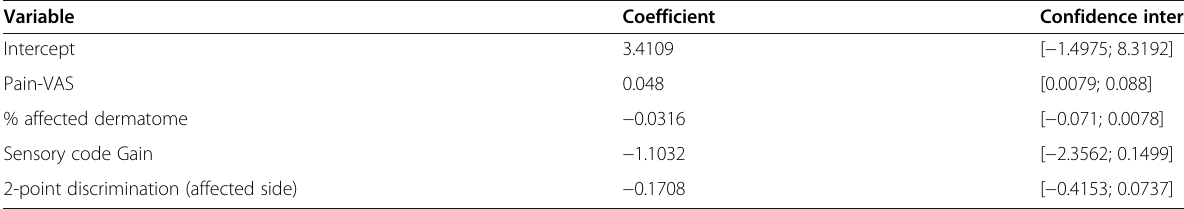
Table 1 Prediction model for neurosensory recovery in PTN after 6 months Variable